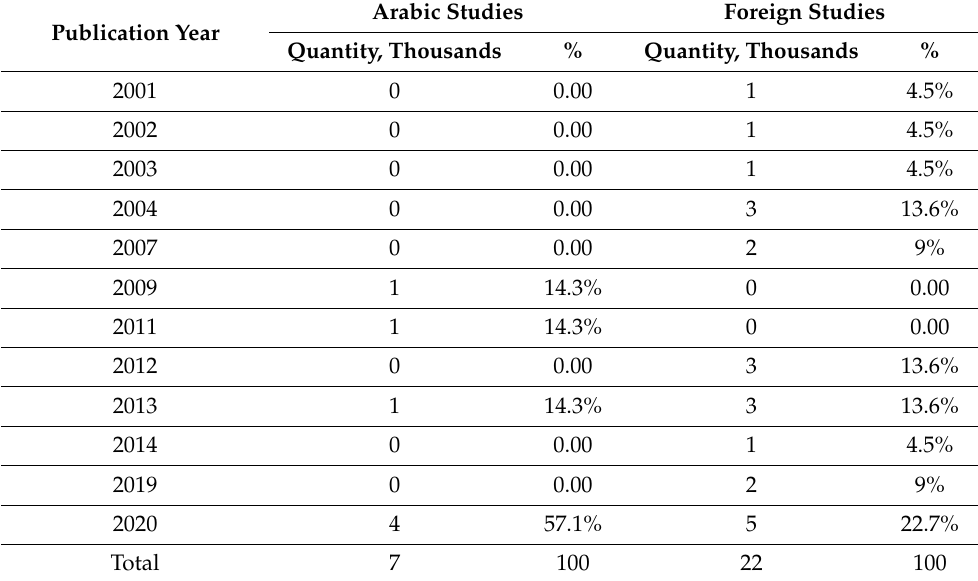
Table 1. Distribution of studies covered by the research sample (2001–2020).